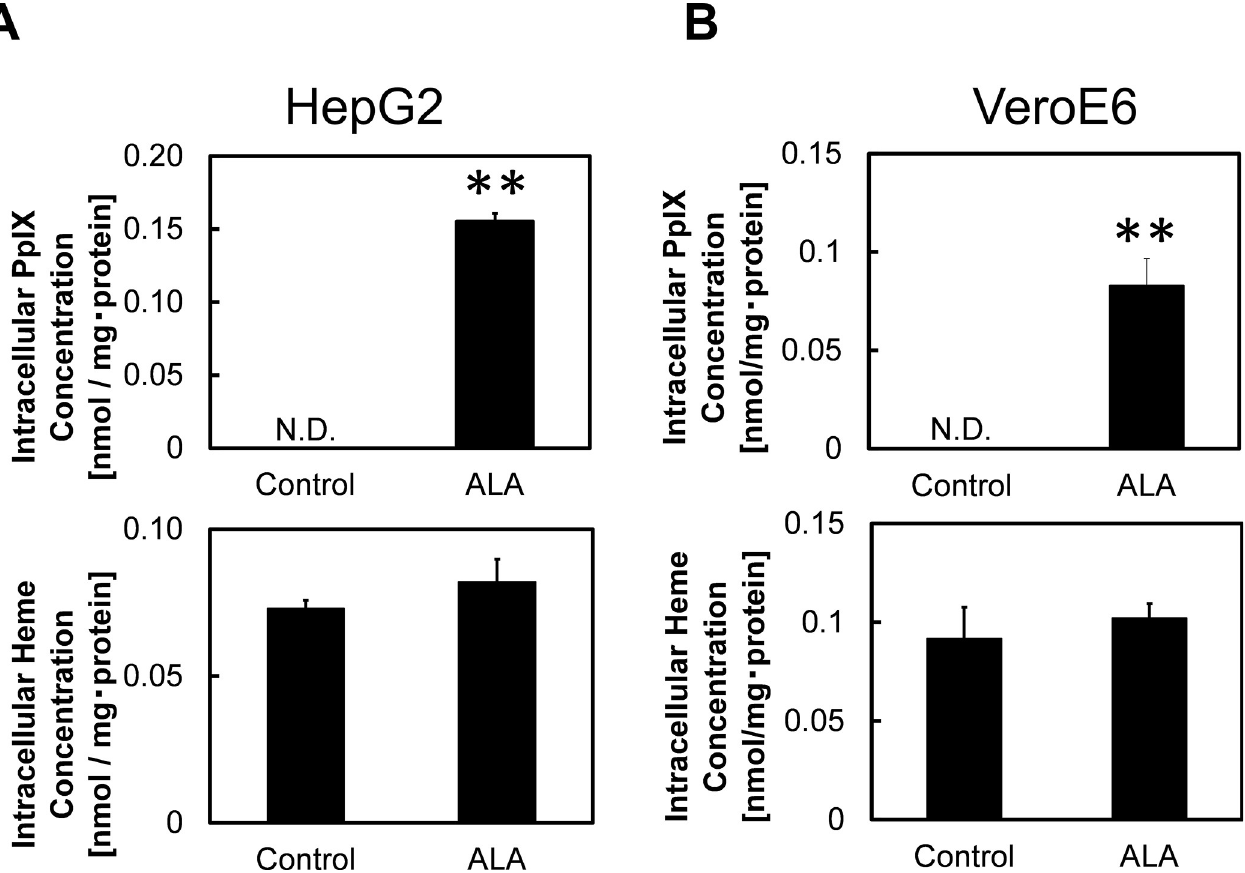
Fig 3. Changes of intracellular PpIX and heme following ALA administration. Concentration of intracellular PpIX and heme in (A) HepG2 cells and (B) VeroE6 cells following administration of ALA. A one-way ANOVA (Tukey’s test) was performed for each data set to identify differences in mean values between treated and untreated samples; �� , p < 0.01. n = 3. Bars represent standard deviation (SD).